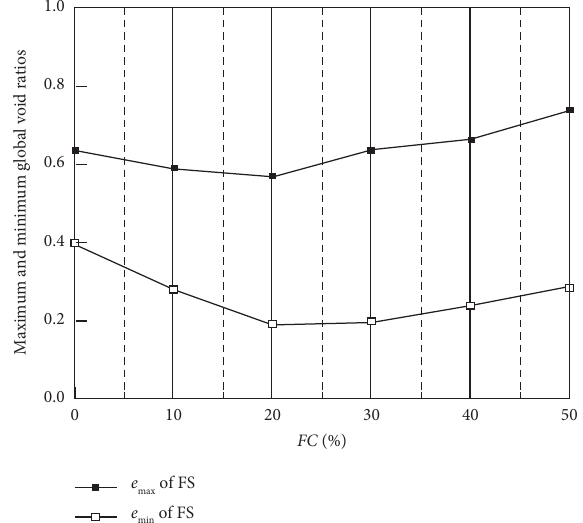
Figure 3: Maximum and minimum global void ratios of FS with various FCs.